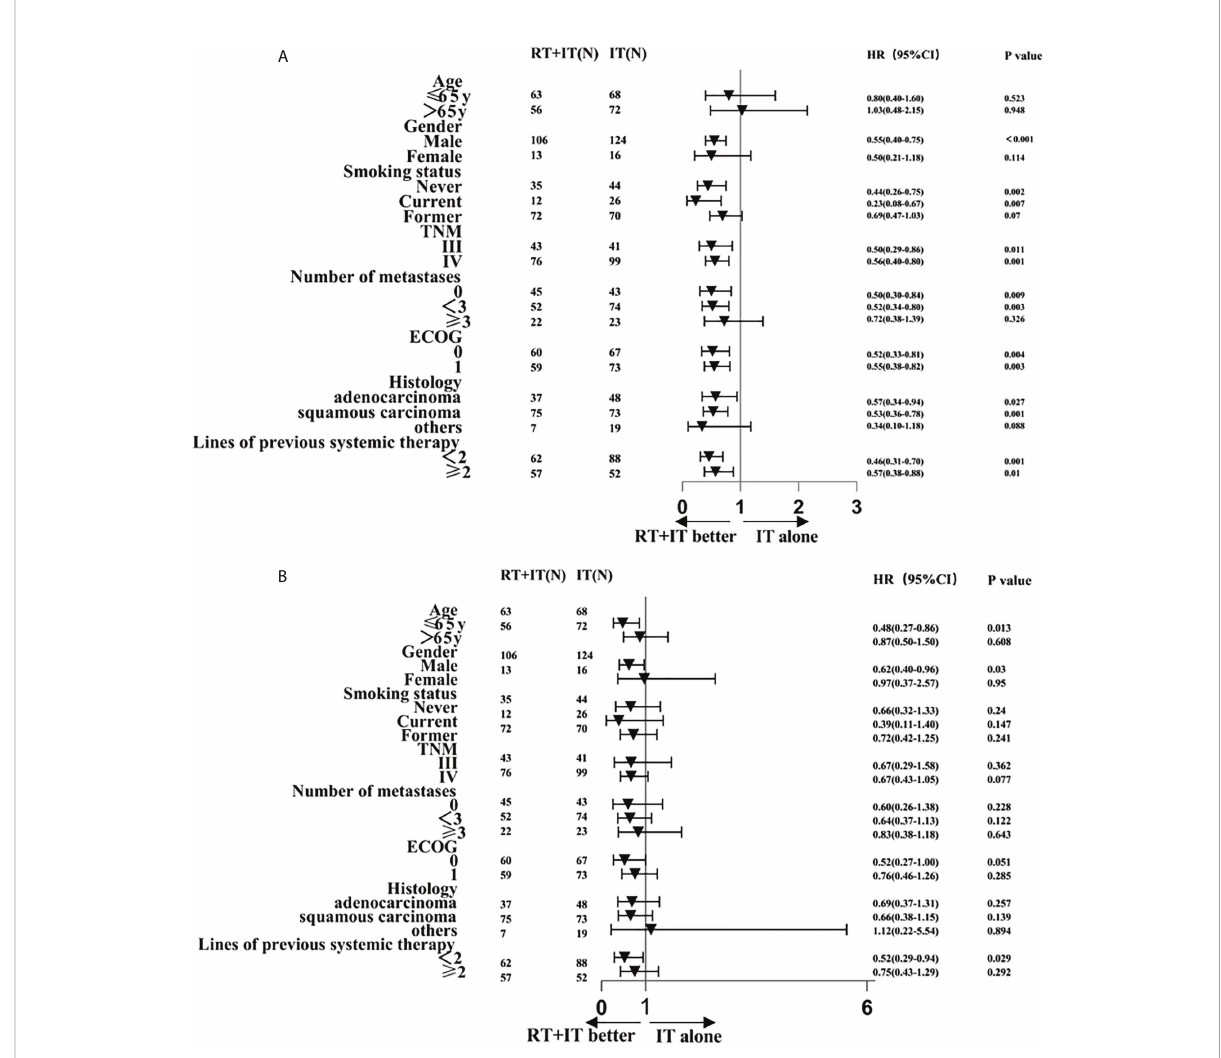
FIGURE 2 Subgroup analysis of factors associated with progression-free survival (A) and overall survival (B)